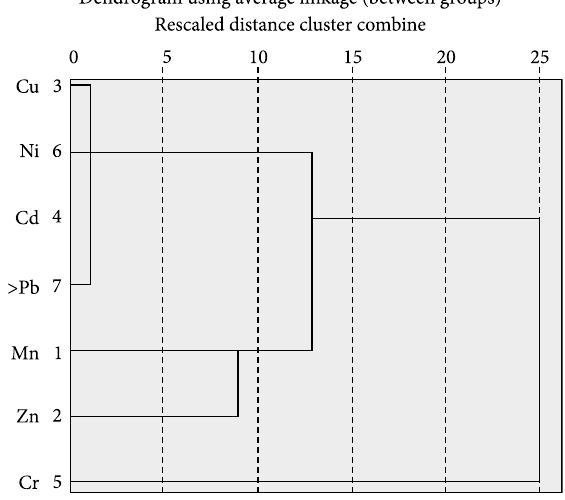
amendmentsFig. 4. Hierarchical dendrogram showing clustering of different metals in plants using Pearson correlation as distance and group linkage